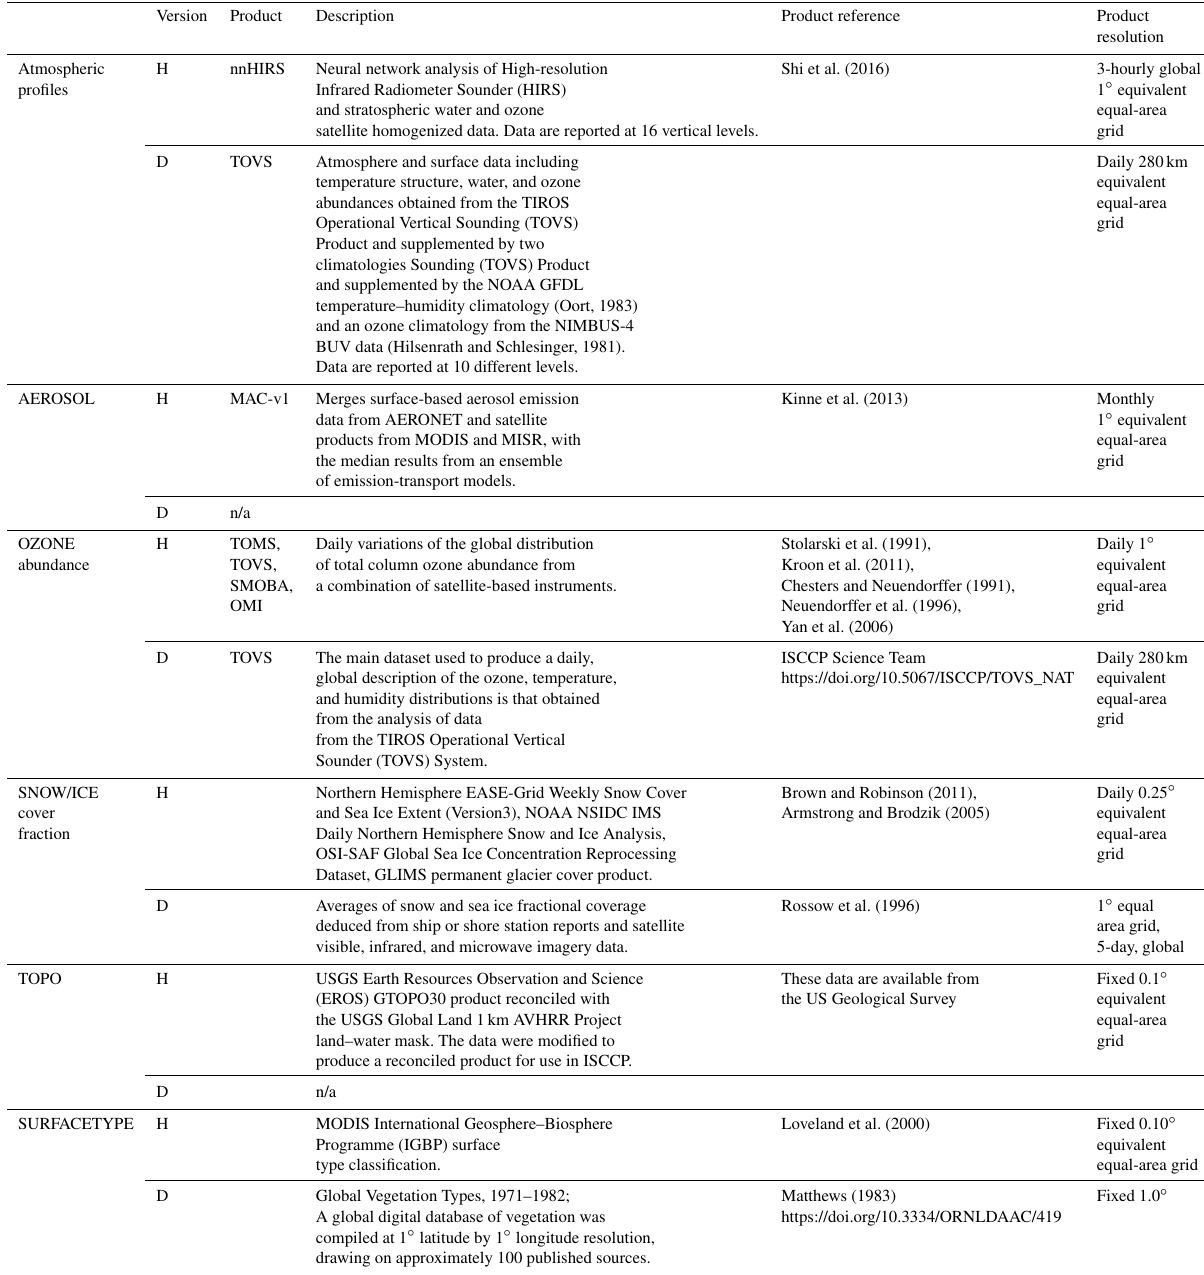
Table 1. List of H-series and D-series ancillary data products including in producing ISCCP cloud and surface products; n/a: not